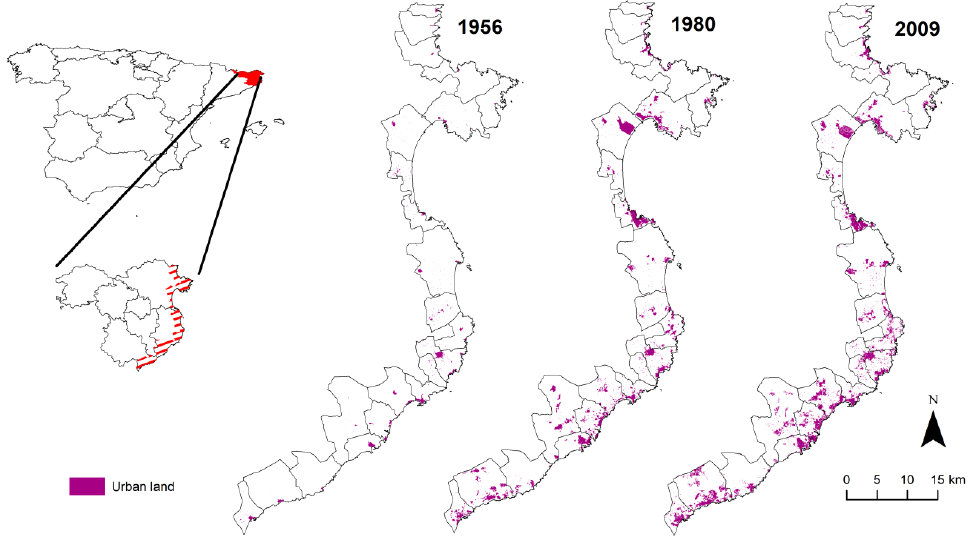
Figure 1. The municipalities of the Costa Brava and its urban growth (1956–2009). Source: [36].